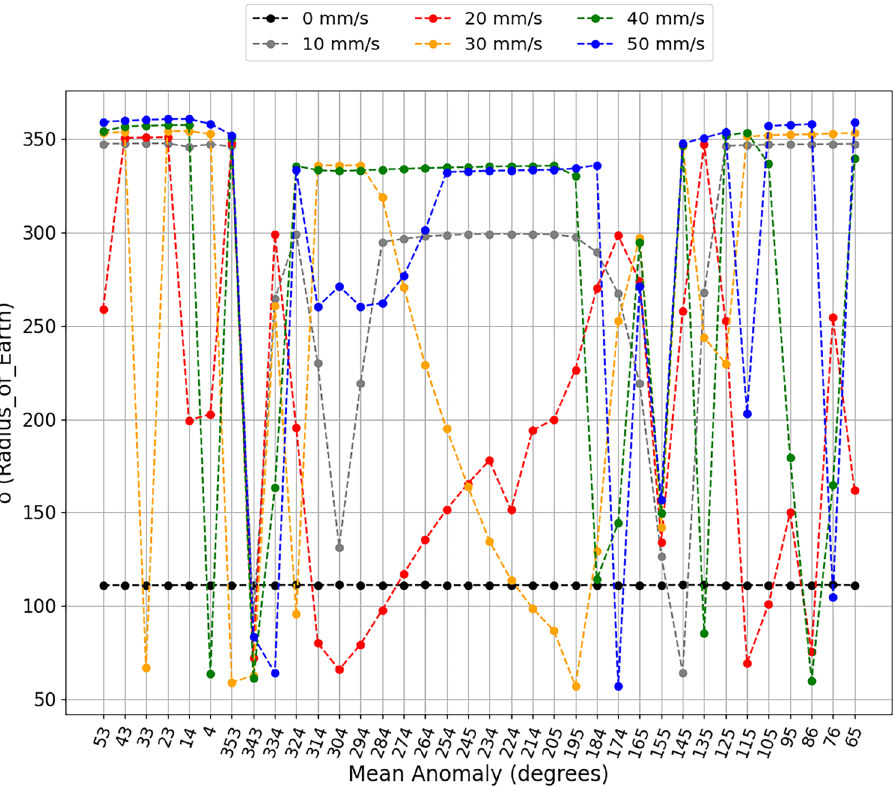
Figure 3. The closest approaches between the asteroid and the Earth along a period of about 100 years ( δ ) (y axis), after positive velocity variations at different mean anomalies (x axis) to simulate different positions for the application of impulse. The black dots are the closest approach of the asteroid to the Earth without the application of impulse. δ is expressed in terms of Earth